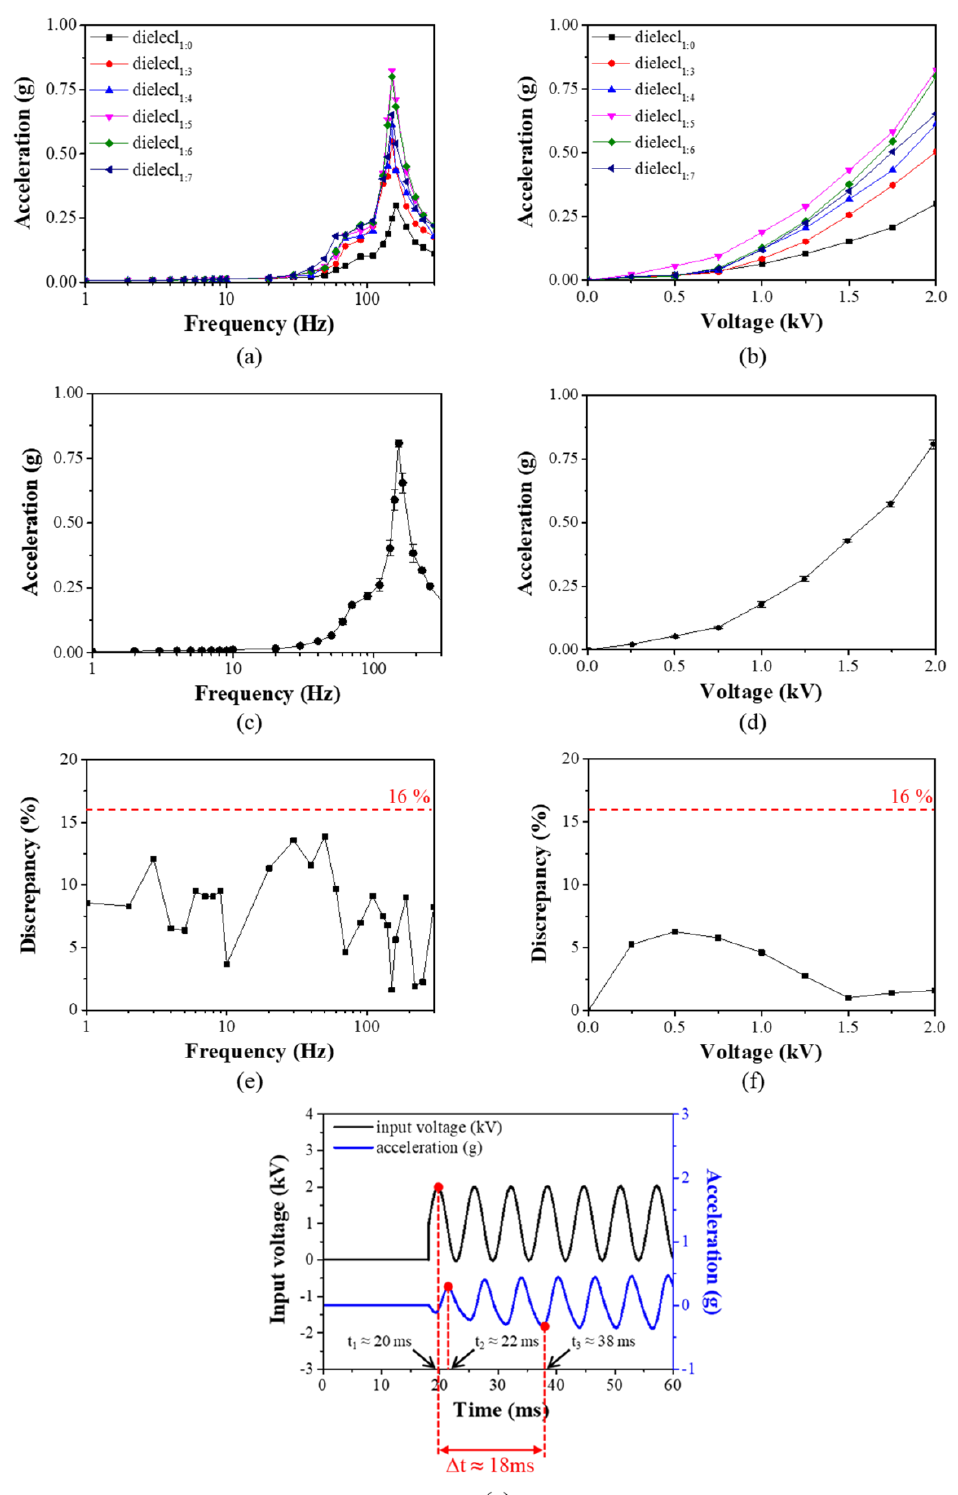
Figure 9. Haptic performance of the proposed actuator: ( a ) vibration output acceleration of the actuator samples according to input frequency; ( b ) vibration output acceleration of the actuator samples according to voltage; ( c ) haptic performance of the prepared five actuators based on dielecl 1:5 as a function of input frequency; and ( d ) haptic performance of the prepared five actuators based on dielecl 1:5 as a function of input voltage; ( e ) discrepancies among the prepared actuators in frequency response; ( f ) discrepancies among the prepared actuators in voltage response; ( g ) response time of the proposed actuator based on dielecl 1:5 .